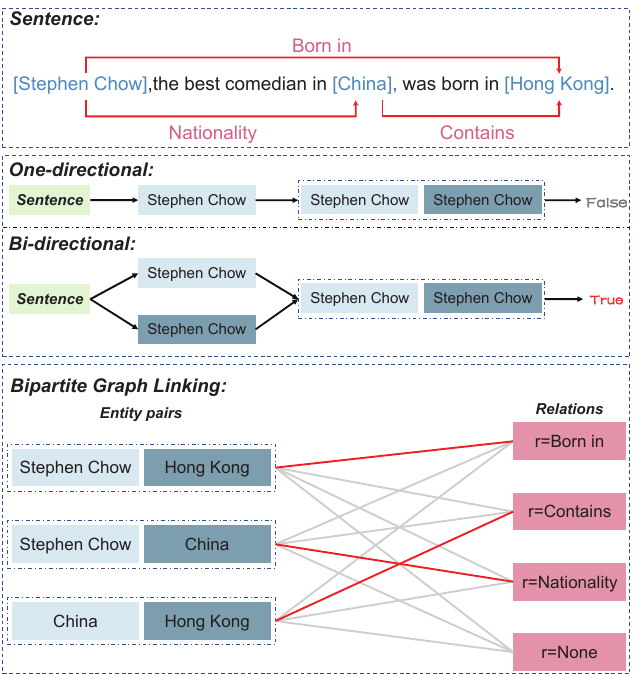
Figure 1. An example of single-directional and bidirectional extraction, as well as the bipartite graph that links entity pairs and